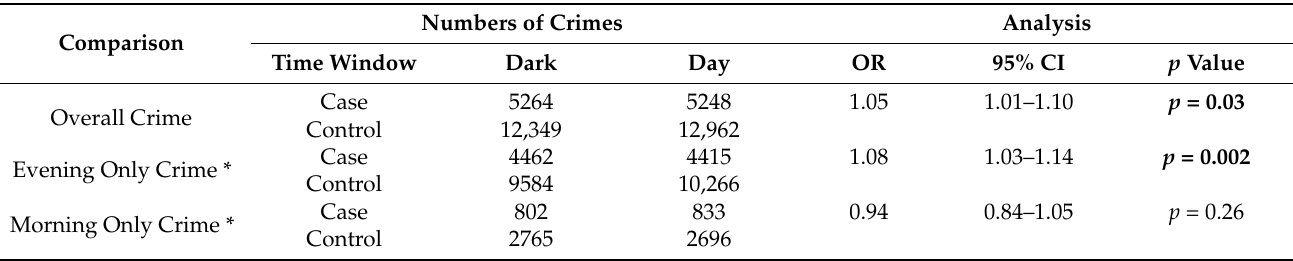
Table 3. ORs and 95% CIs associated with the change in crime frequency at dark compared to daylight. The associated p -values indicate whether the OR is significantly different to 1.0 (significant differences noted in bold font).